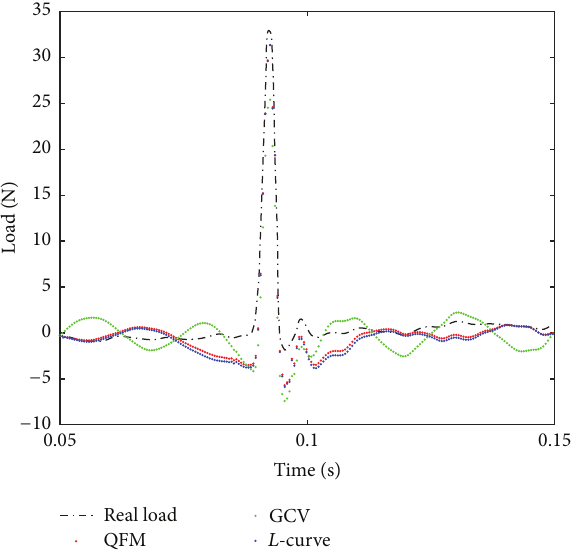
Figure 31: Local impact load in experiment of MIMO